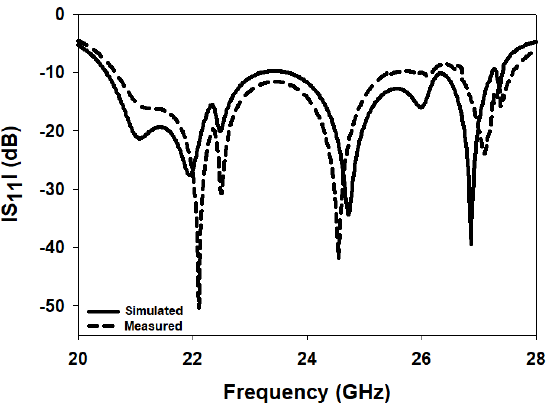
Figure 17. The simulated and measured S 11 of the integrated DRA and perforated substrate configuration.